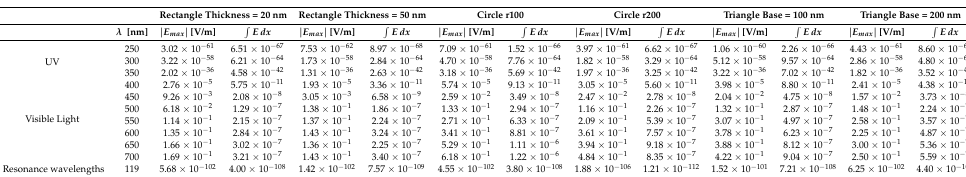
Table A6. Summary table of the results obtained for the aluminium nanostructures—Probe